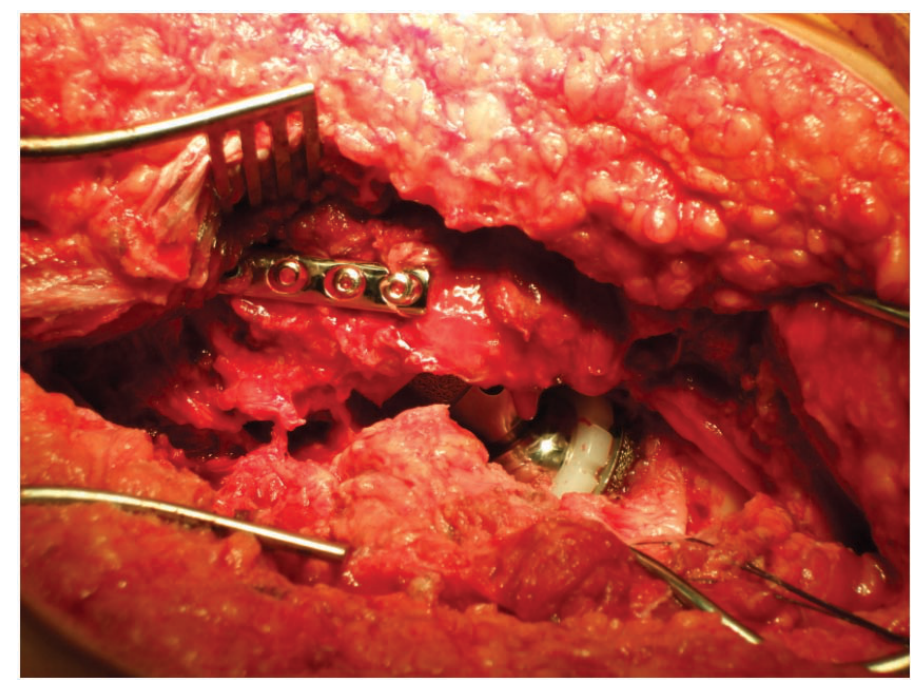
Figure 2. Dysplastic hip